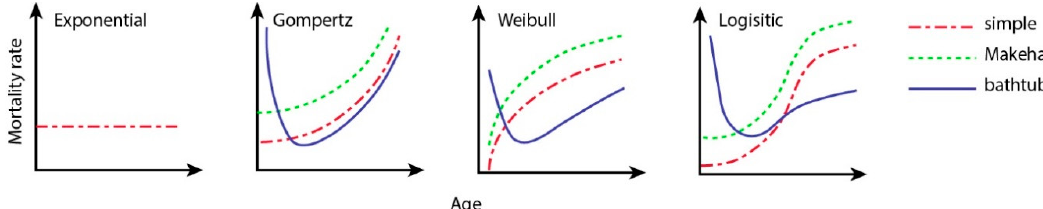
Figure 1. Possible mortality trajectories, µ ( x | θ ) when θ is a vector of mortality parameters to be estimated, resulting from the four models included in BaSTA. Mortality or hazard rate is shown on the y -axis, with age as a continuous variable on the x -axis. The line styles represent examples of each model shape that are possible to test: simple, Makeham, and bathtub. The exponential model is only applicable in a simple format.